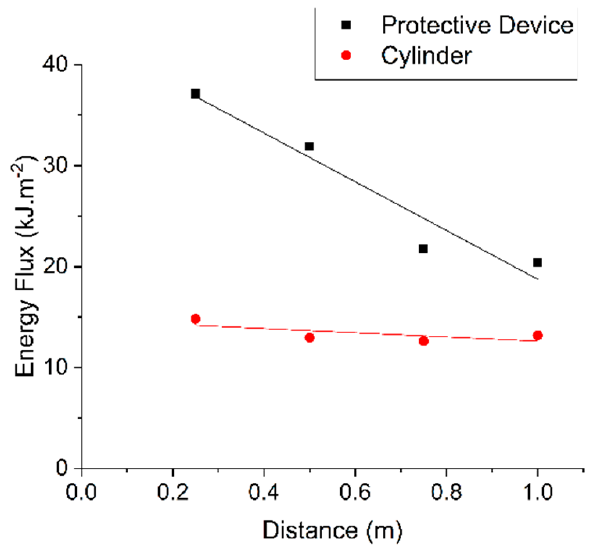
Figure 8. Energy flux on surfaces of the cylinder and protection for laboratory tests with the protective device.